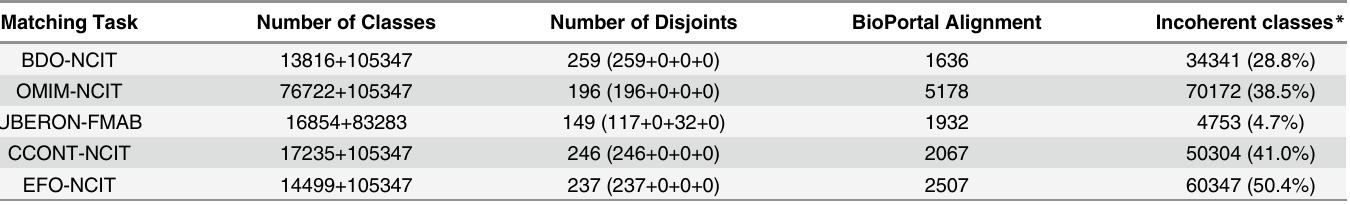
Table 5. Total number of classes and disjointness axioms of the matched ontologies, the size of the of the original (unrepaired) Bioportal align- ment, and the number of incoherent classes for each of five Bioportal matched ontologies. The number of syntactic, cardinality, functional and Object based disjointness axioms relative to the each matching task are shown in parentheses.